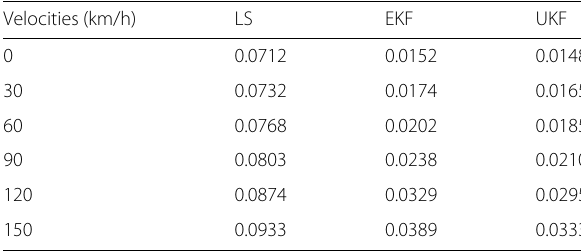
Table 1 The mean for BEM-based channel estimation methods in different velocity Velocities